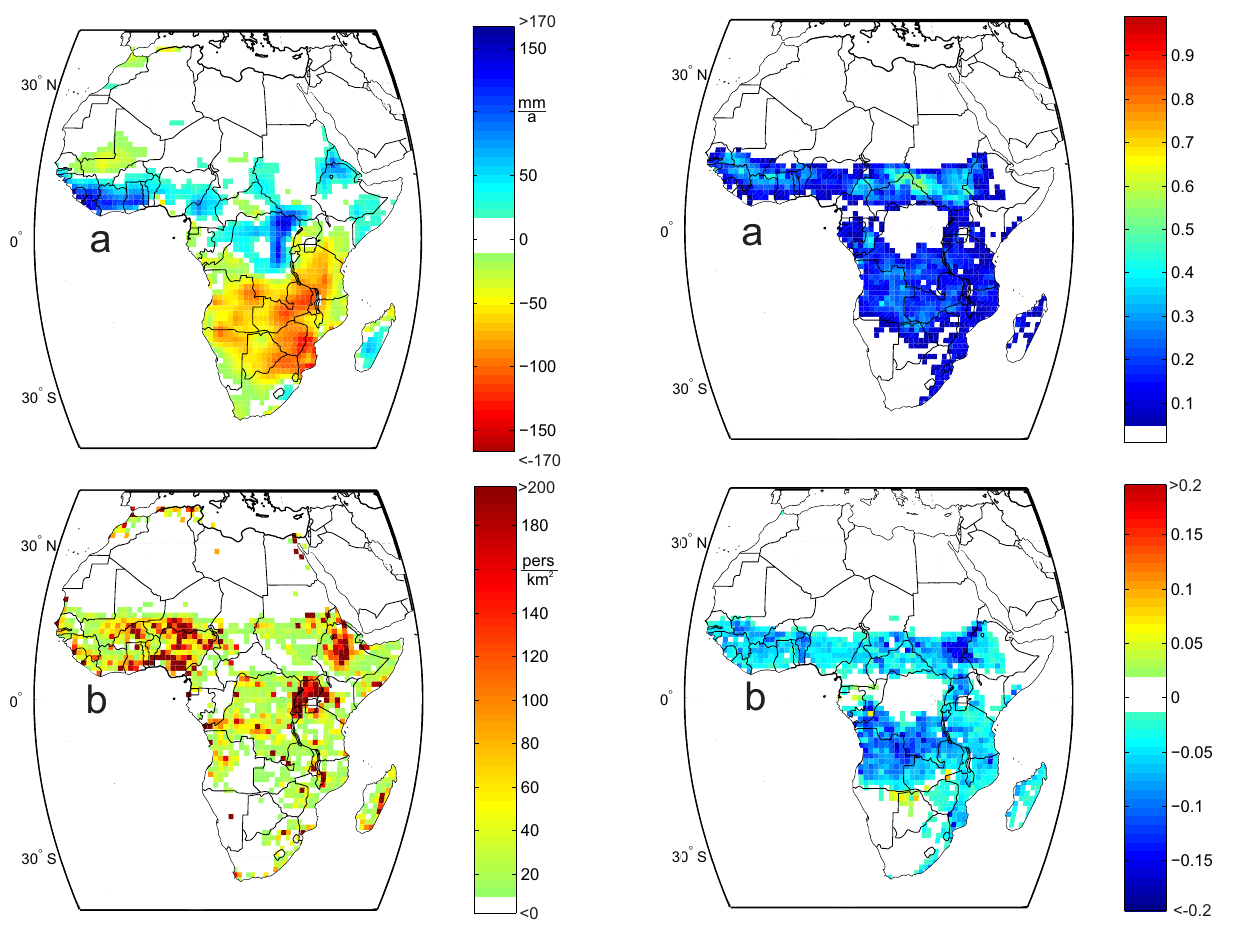
Fig. 10. Projected changes in mean annual precipitation (a) and population density (b) for the SRES storyline B1 and the ECHAM climate model (see methods section). Panels are plotted as the dif- ference between the average of the years 2050 to 2060 and 1990 to 2000.